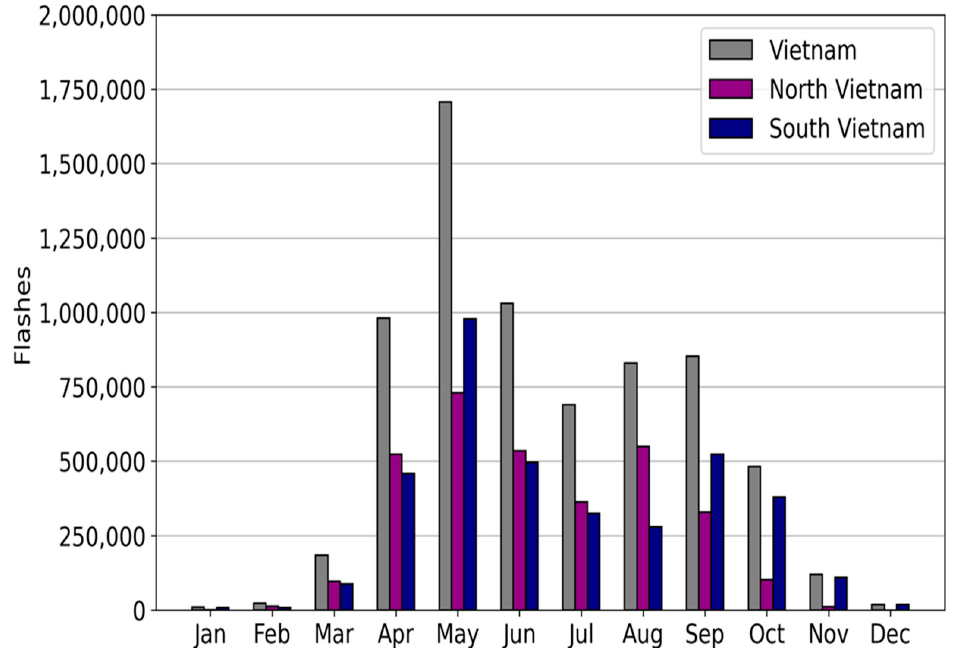
Figure 3. Monthly means of lightning flashes in the whole of Vietnam, North Vietnam, and South Vietnam in 2015–2019.